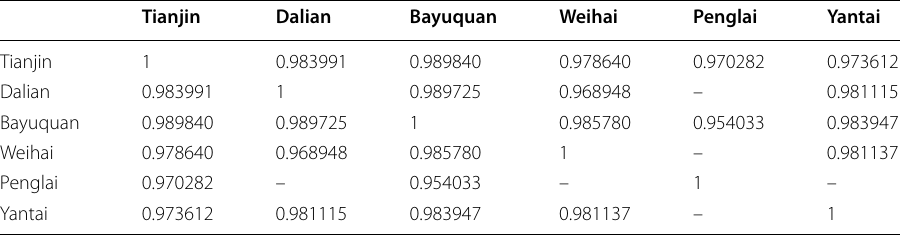
Table 3 Trajectory similarity matrix between the 6 ports